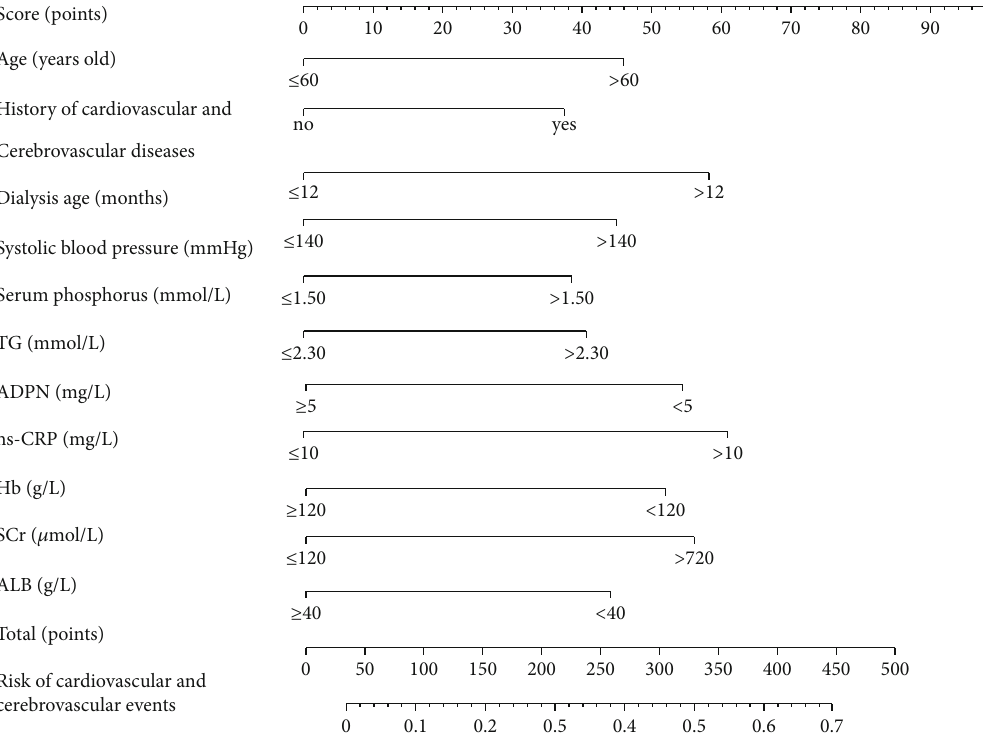
Figure 1: Nomogram model for predicting the risk of cardiovascular and cerebrovascular events in diabetic nephropathy patients receiving maintenance hemodialysis.